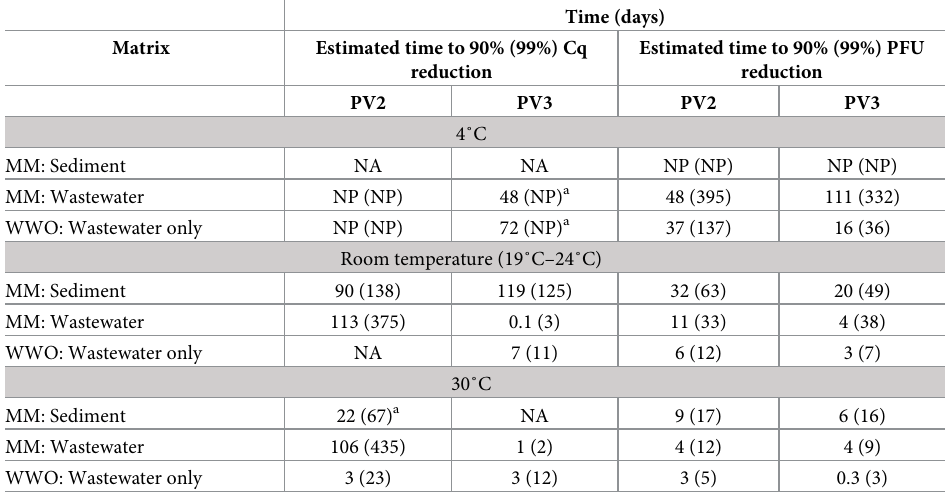
ysis of variance (ANOVA) assessed if their inclusion added significant value to the analysis. When T90 was the dependent variable, the inclusion of the Temperature and Sediment data. The model coefficients and significance values are shown in Table 2. The reference for the linear model was PV3 in the WWO matrix at 4˚C with the RT-qPCR method, and the T90 associated with these conditions is represented by the intercept in Table 2. The PV2 and Sedi-